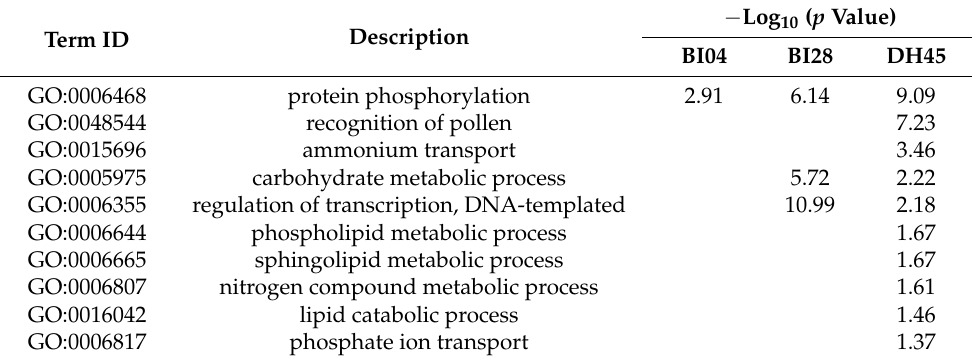
Table 4. Biological process terms of GO enrichment for 1027 DEG HP in